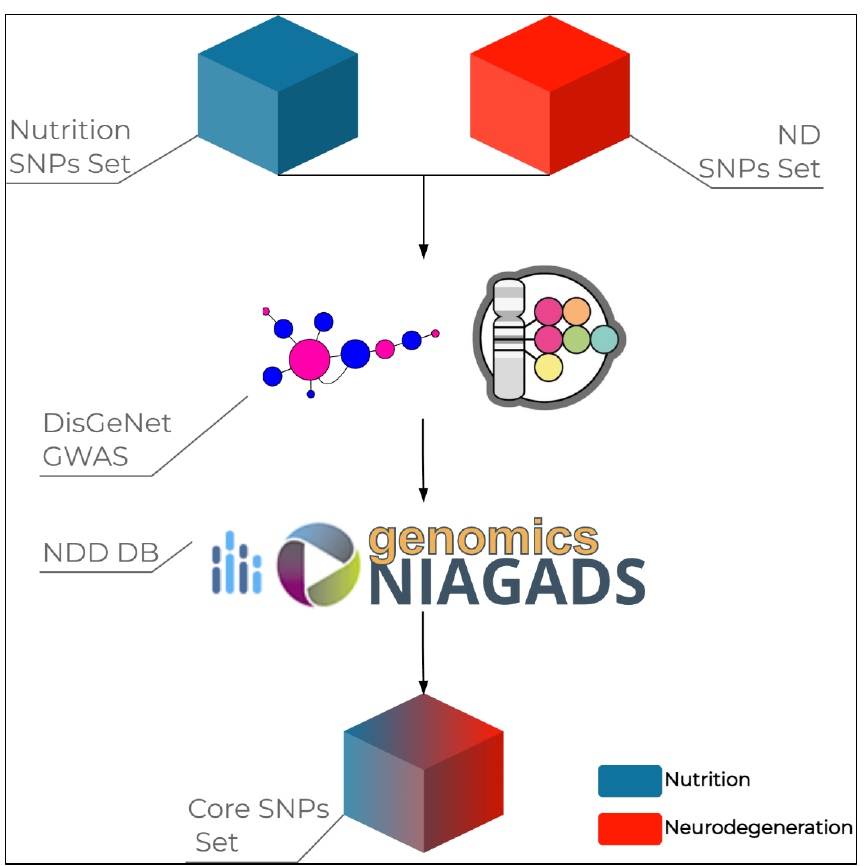
Figure 1. The research workflow utilized to identify SNPs with effects both on nutrition and neurodegenerative diseases.